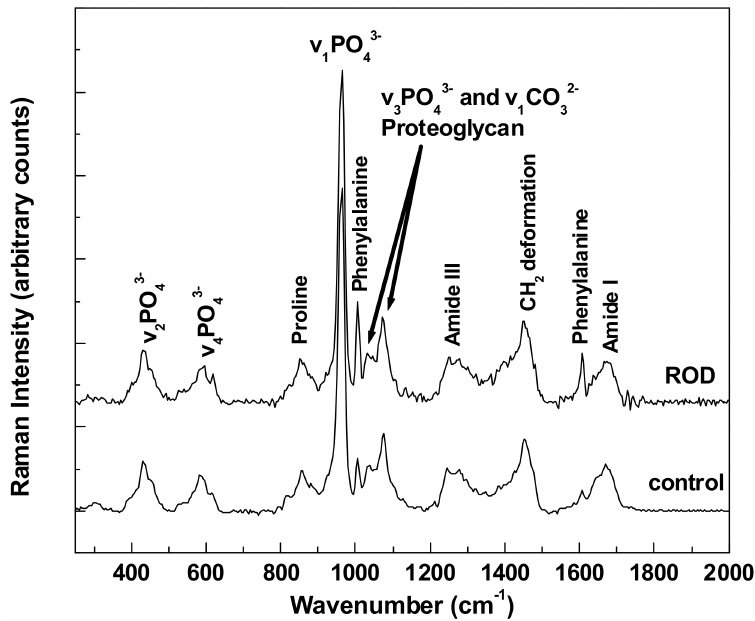
Figure 1. Representative Raman spectra of control and renal osteodystrophy (ROD) bone samples obtained by averaging hundreds of thousands of accumulated